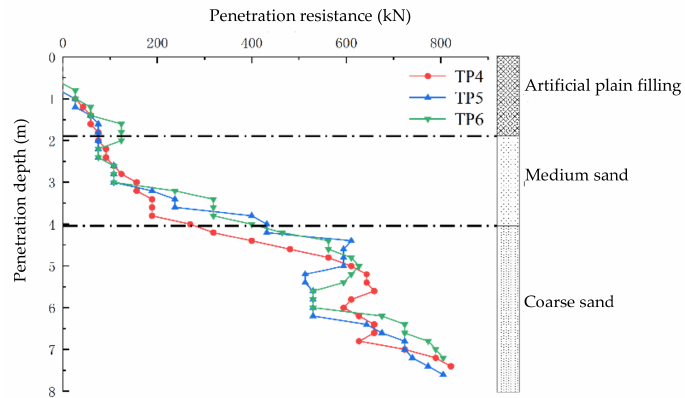
Figure 3. Penetration resistance curve for condition b